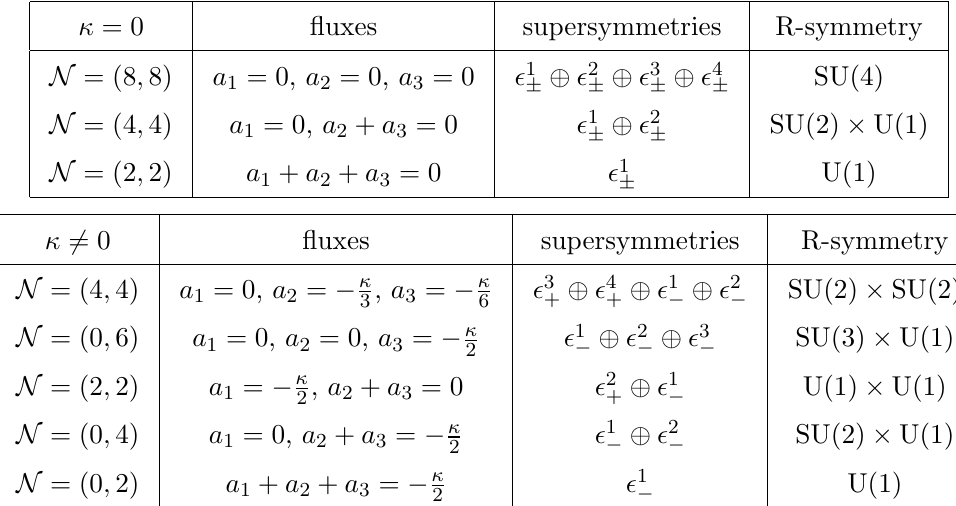
Table 11 . Classi(cid:12)cation of topologically twisted 4d N = 4 SYM on Riemann surfaces of